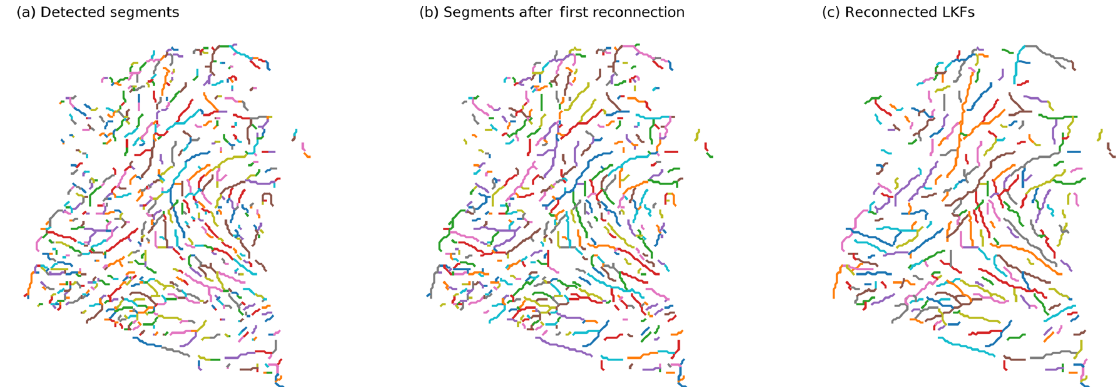
Figure 2. (a) Detected segments and the results of (b) the first reconnection step and (c) the second reconnection step for RGPS deformation data from 1 January 2006. Each color denotes a different segment or LKF. Due to a limited number of colors, different segments or LKFs can have the same color. The output of the second reconnection step is the final output of the LKF detection algorithm.